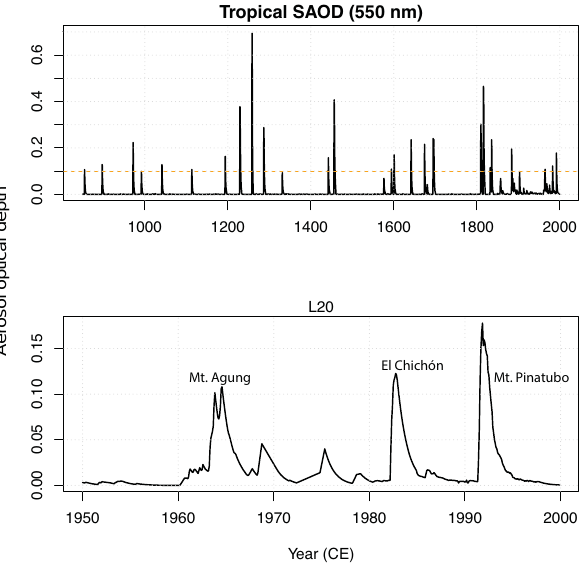
Figure 1. Aerosol optical depth (AOD) used to force the NASA GISS ModelE2-R over the last millennium and (bottom) zoomed in on the period 1950–1999 (Sato et al., 1993; Crowley and Unter- man, 2013) as discussed in the text. AOD is the vertically integrated (15–35km) and latitudinal average from 30 ◦ S to 30 ◦ N. Note dif- ference in vertical scale between graphs. Orange dashed line marks the AOD threshold for defining a LM eruption in the present study. Eruption events defined in the text must sustain the threshold AOD for at least 1 year, so not all events above the orange dashed line are used in the